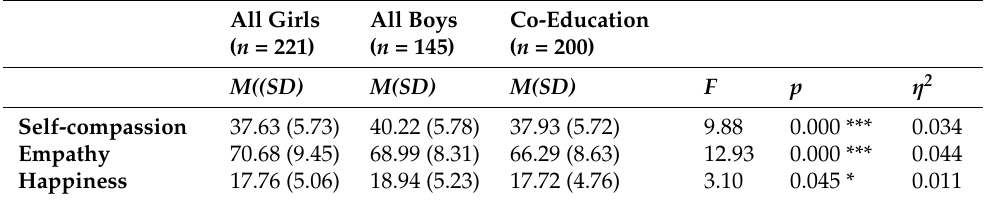
Table 6. Effect of late adolescents’ institute type on self-compassion, empathy, and happiness ( N =